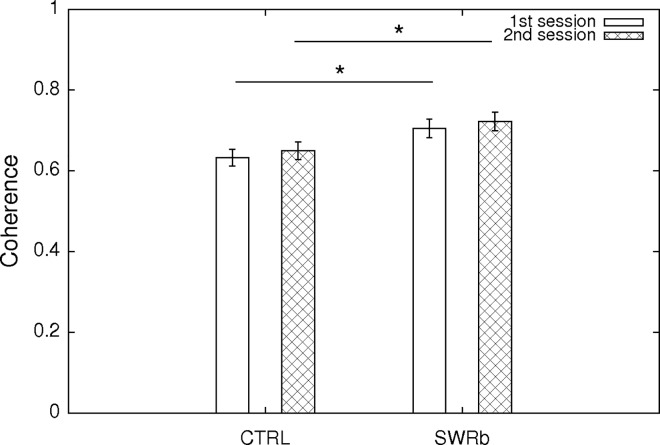
Coherence of the cells.Mean ± SE of the coherence of the CA1 pyramidal neurons at first exposure (open bars) and second exposure (cross-hatched bars) to the same environment. Coherence values at the first exploration session are significantly different between the control and SWR-block condition (p = 0.005; Oneway ANOVA), and the similarly for the second exploration session (p = 0.012; Oneway ANOVA) 117 (SWR block) + 116 (CTRL) pyramidal cells were used for this analysis.